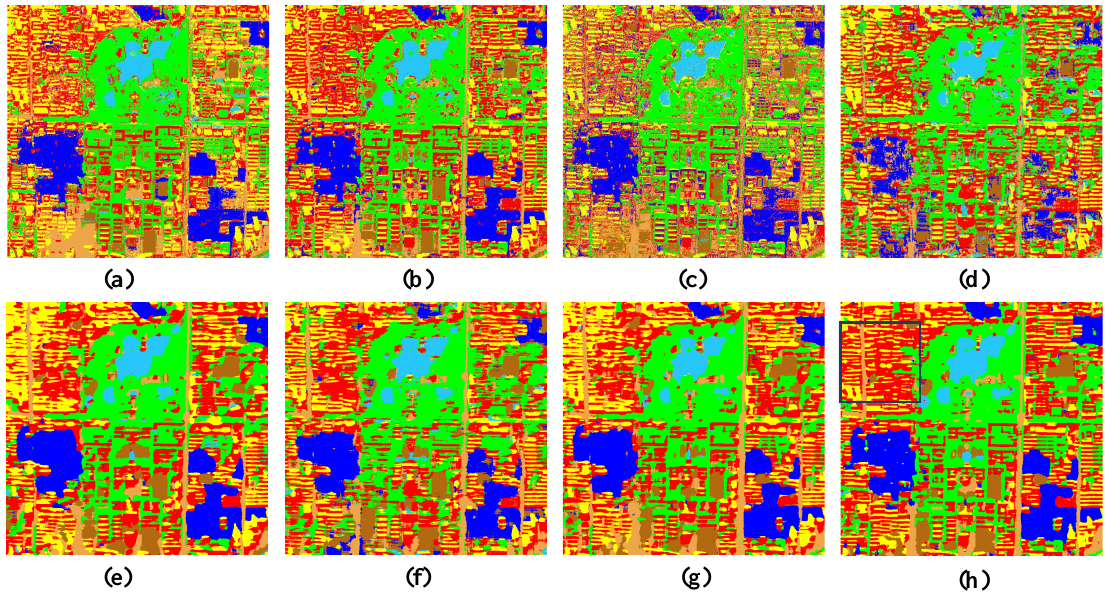
Figure 7. Classification maps with different methods on Xi’an Urban dataset. ( a ) EMAP. ( b ) CAE. ( c ) RNN. ( d ) SCPF-ResNet. ( e ) CNN-MS. ( f ) CNN-PAN. ( g ) SFNet. ( h )